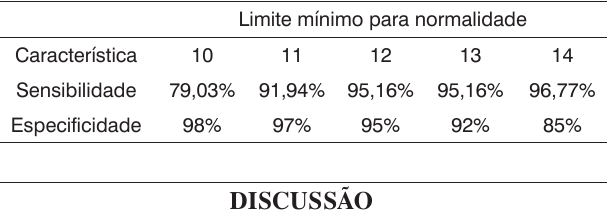
Tabela 2. Variação da sensibilidade e